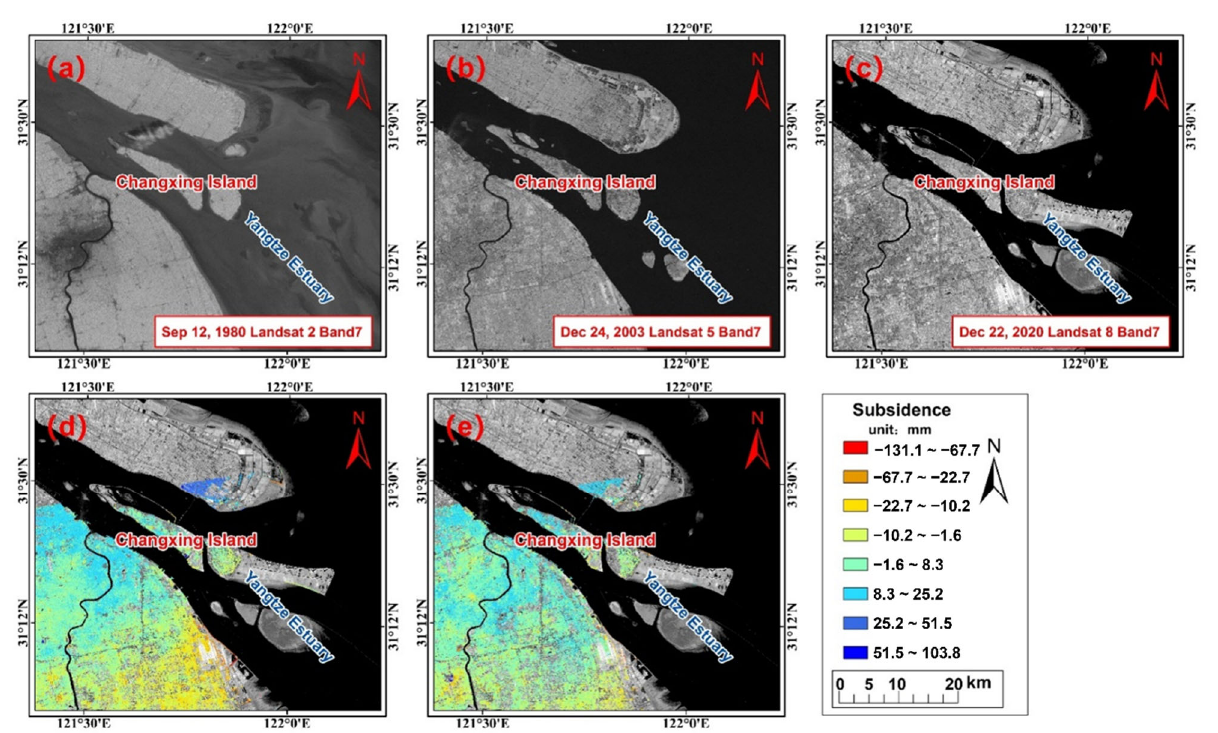
Figure 13. Time series change in the Yangtze River Estuary. ( a ) Landsat 2 Band7 in September 1980; ( b ) Landsat 5 Band7 in December 2003; ( c ) Landsat 8 Band7 in December 2020; ( d ) accumu- lated deformation at the estuary during 2016–2017; ( e ) accumulated deformation at the estuary during